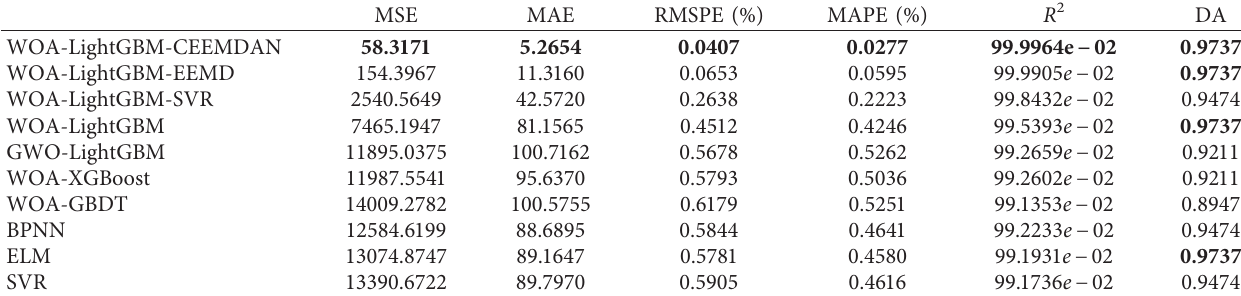
Table 6: Forecast accuracy table for hog